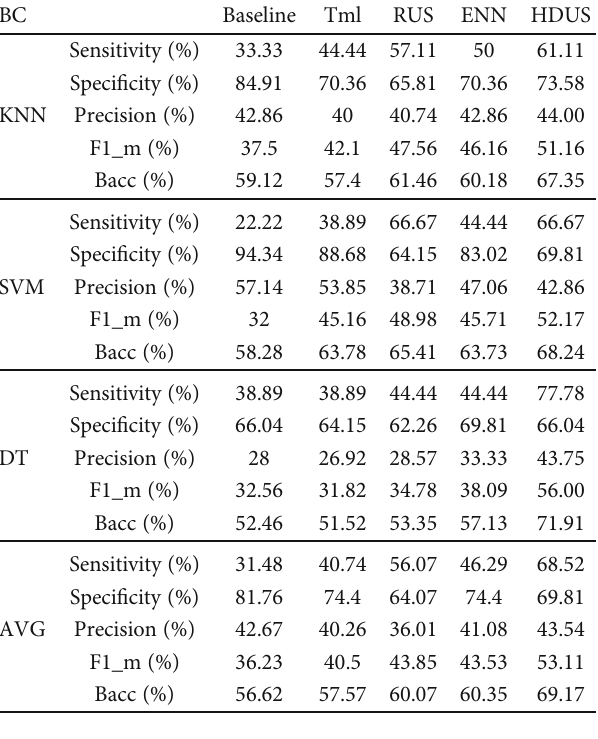
Table 6: Evaluation results for PIMA dataset using classi fi ers (KNN, SVM, and DT) and models (baseline, Tml, RUS, ENN, and HDUS).